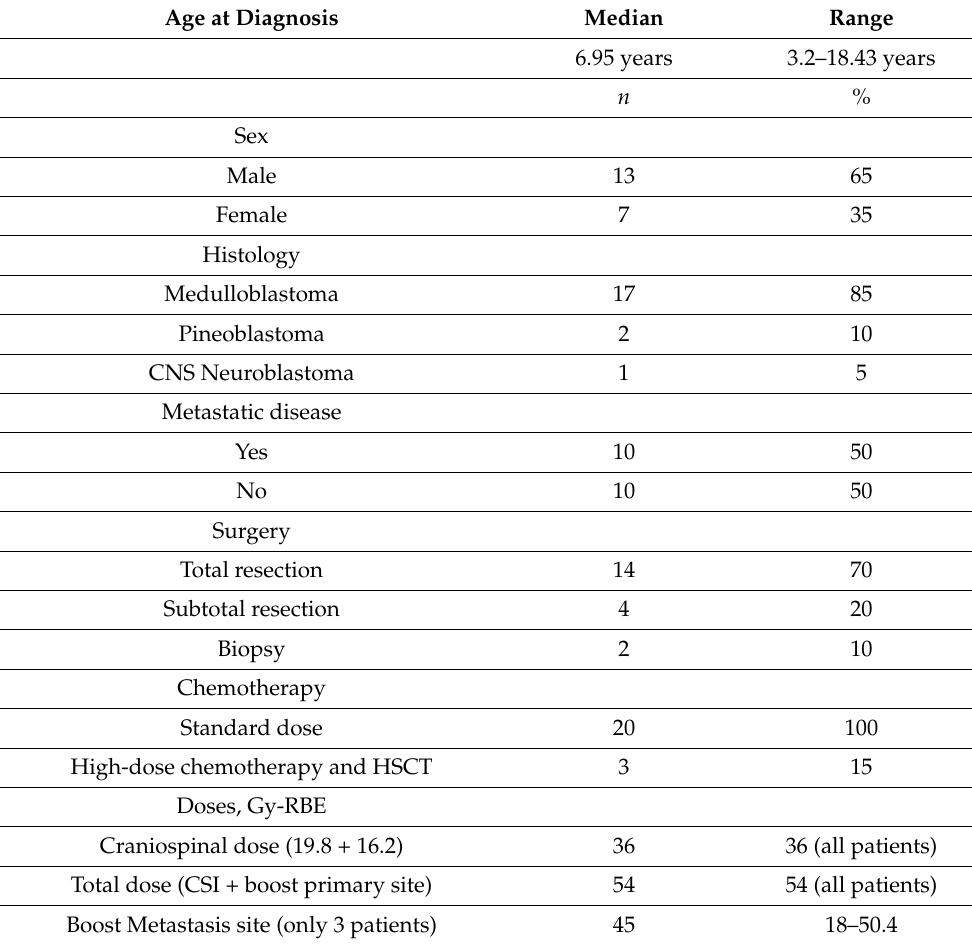
Table 1. Patients’ characteristics and treatment